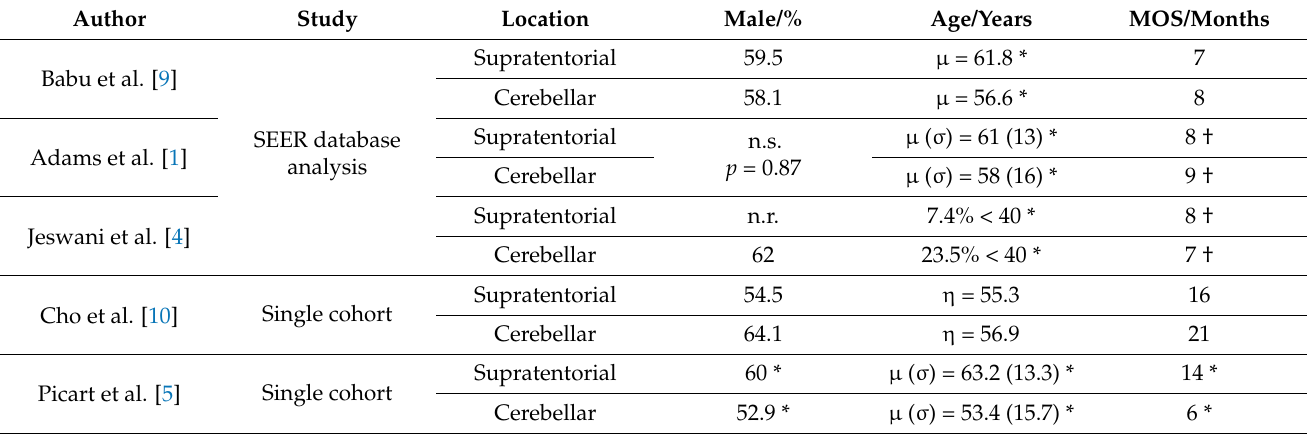
Table 1. Comparative summary of cerebellar and supratentorial high grade glioma